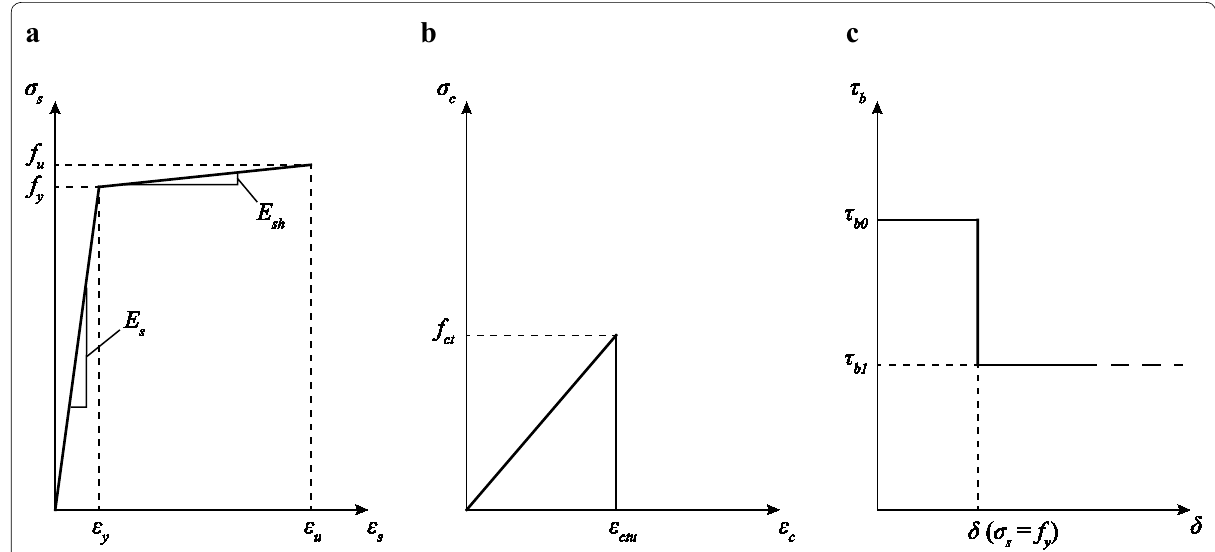
Fig. 2 Constitutive relations employed in the extended tension chord model: a Bilinear steel stress–strain law. b Concrete tensile stress–strain behaviour. c Steel–concrete bond–slip